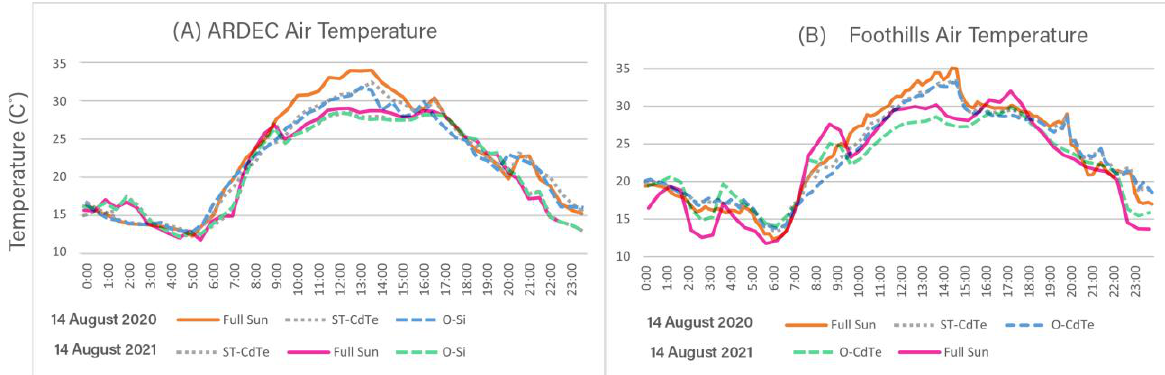
Figure 5. Air temperatures across both sites at 30 cm of height. ( A ) ARDEC 2020 and 2021 and ( B ) Foothills 2020 and 2021.